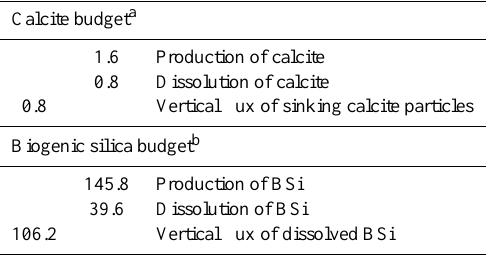
Table 6. Annual budget ∗ of N over the global